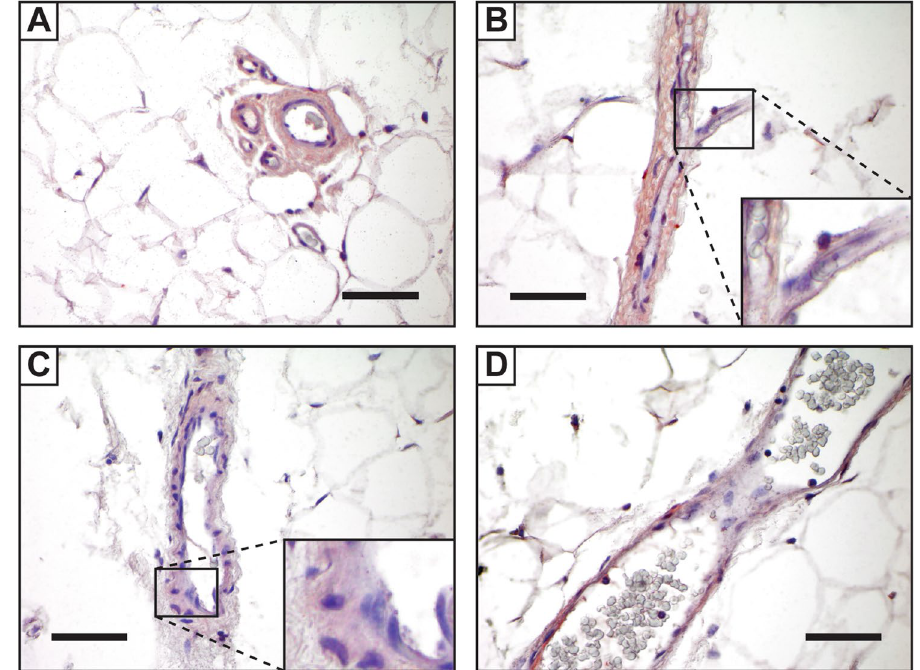
Figure 1. Immunohistochemical detection of WISP-1 protein in human adipose tissue. ( A) WISP-1 immunoreactivity within the vascular wall of small caliber vessels in cross section. ( B ) WISP-1 immunoreactivity within a venule (center) and branching capillaries in longitudinal cross section. ( C , D ) WISP-1 immunoreactivity in larger caliber veins. Scale bars = 25 μ